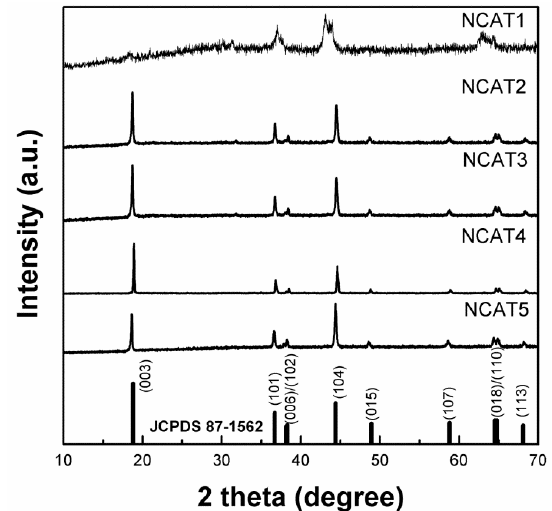
Figure 7. XRD patterns of as prepared NCA cathode material sintered at various temperature for 10